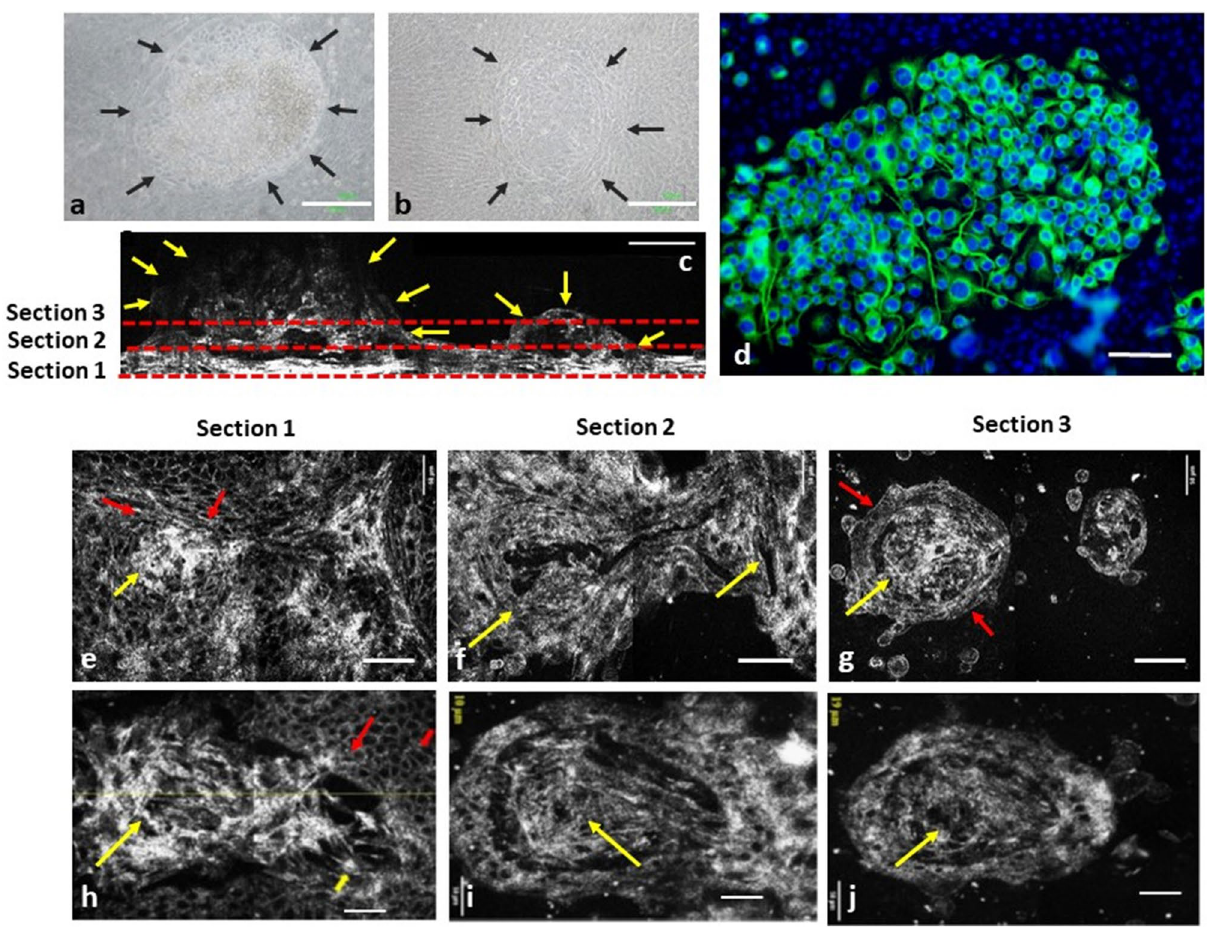
Figure 5. The immunocytochemical, 2D cross-sectional, and en face FF-OCT images of a complex culture system with different types of cells mixed. ( a , b ) Phase contrast inverted microscopy demonstrated that two DACNs grew on a sheet of epithelial cells. ( c ) FF-OCT cross-sectional images of the two DACNs. The height of 1 DACN was 150 μm. ( d ) Fluorescein microscopy en face images of the immunocytochemical staining of DACNs (Green: beta-III tubulin; Blue: Hoechst 33258 for nucleus). The staining pattern demonstrated two cell types inside and outside DACNs. ( e–g ) FF-OCT en face image sequence of the culture cells. Section 1 ( e , h ), section 2 ( f , i ), and section 3 ( g , j ) represent the cell at 5 µm, 20 µm, and 50 µm above the bottom of the culture plate. ( e , f , g ) Sequential images in an area with 2 DACNs illustrated in a single field. Red arrows: epithelial type of cells spread at the bottom of the culture plate, and covered the surface of DACNs. Yellow arrows: cells in the centre of DACNs exhibited different morphologies compared with epithelial cells. ( h , I , j ) Sequential images from an area with another DACN in a single field. Red arrows: epithelial cells spread at the bottom of the culture plate and covered the surface of DACNs. Yellow arrows: cells in the centre of DACNs exhibited different morphologies to epithelial cells. ( a , b ) scale bar = 200 μm, (c-j), scale bar = 50 μm. DACN: directly adherent colonies of neuron- like